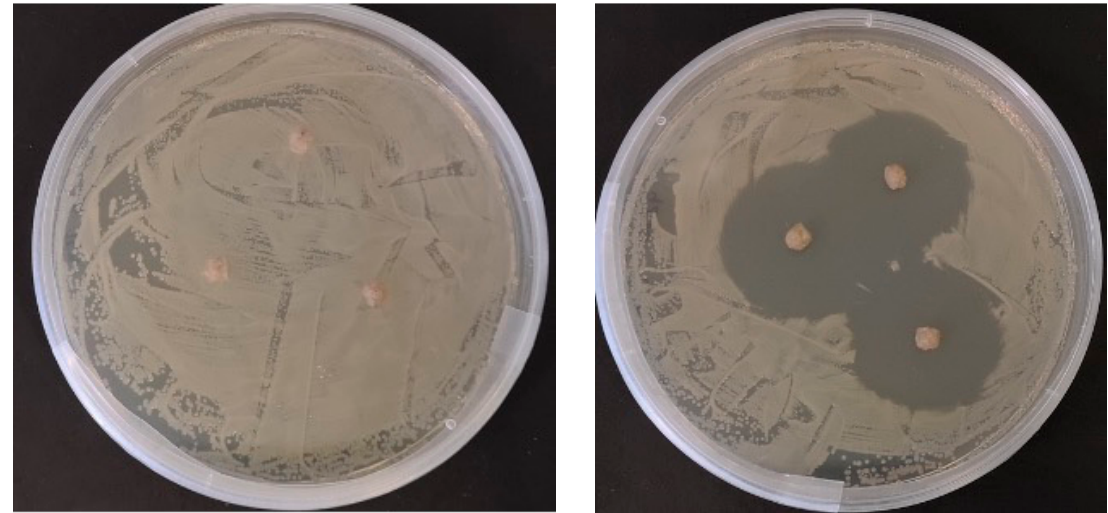
Figure 1. Antimicrobial activity of control and oxytetracycline-coated diets on Aeromonas hydrophila bacterial lawns.